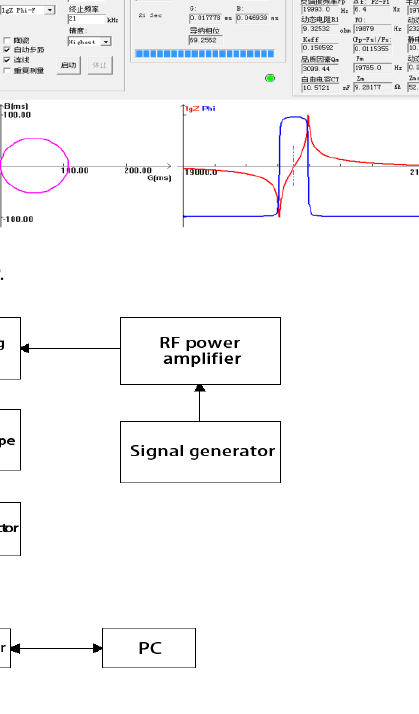
Figure 4. Frame Diagram of Acoustic Vibration Component Dynamic Performance Test System.